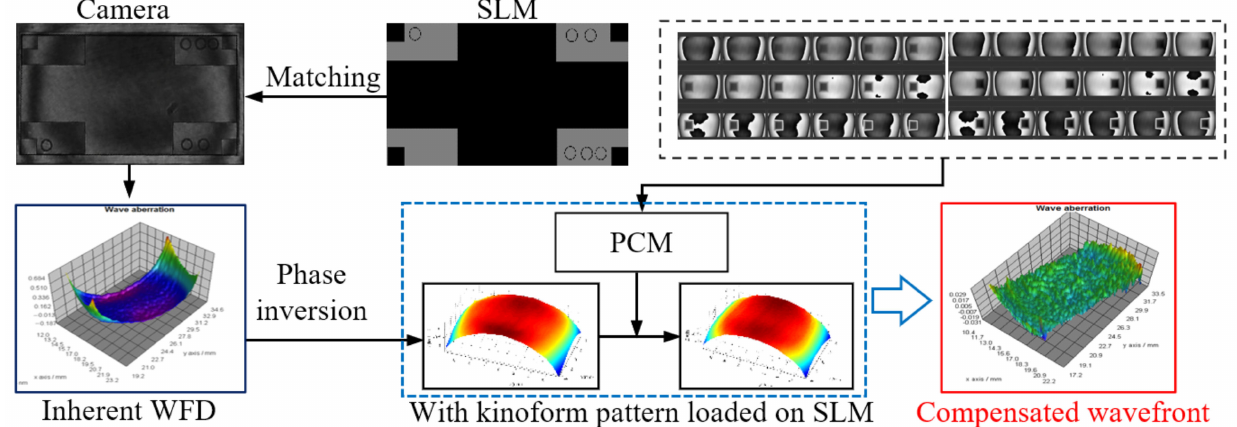
Figure 9. The schematic experimental